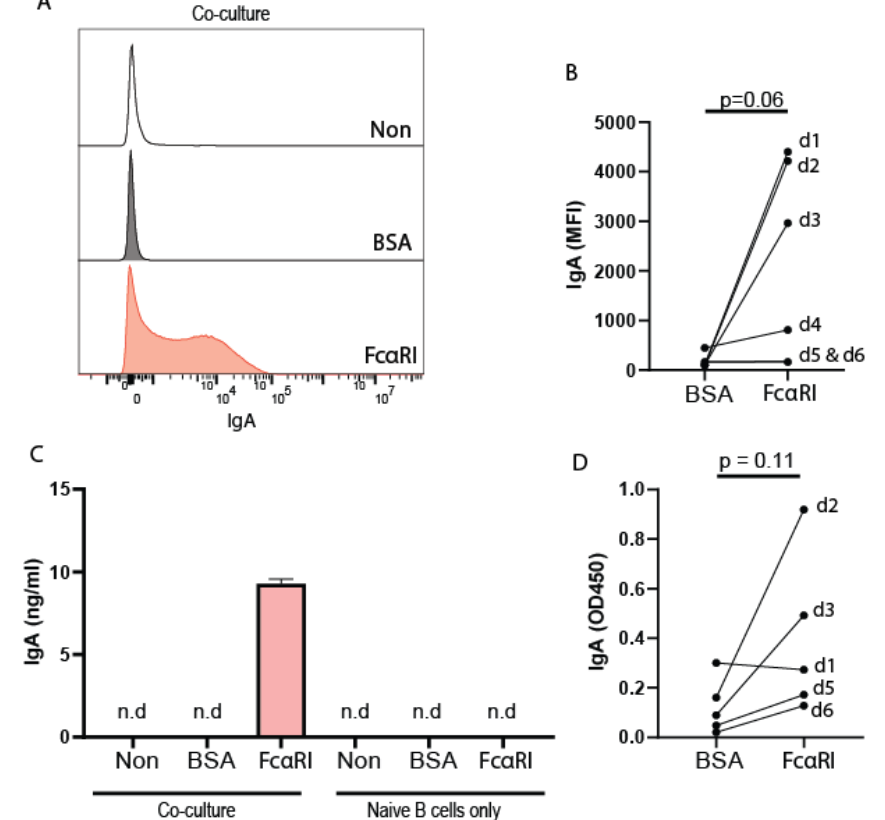
Figure 5. Fc α RI-stimulated monocytes induce IgA class switching in naïve B lymphocytes. Mono- cytes were stimulated with BSA- or IgA-coated (activating Fc α RI) beads and cocultured with pe- ripheral naïve B cells for 7 days in the presence of interleukin-4, anti-IgM, and anti-CD40 antibodies. ( A ) Representative histogram demonstrating IgA surface expression by B lymphocytes after cocul- ture with monocytes treated without beads (non; white), with BSA-coated beads (gray) or IgA- coated beads (Fc α RI) (red). ( B ) Quantification of the mean fluorescent intensity of IgA on B lympho- cytes of six donors. ( C ) Representative ELISA demonstrating secreted IgA in the supernatants of co- cultured naïve B cells with monocytes treated without beads (non), with BSA-coated beads, or with IgA-coated beads (red). Naïve B cells in the absence of monocytes were cultured with beads as a negative control. ( D ) Quantification of IgA secretion by B cells in five donors. Donor numbers in ( B , D ) correspond. Not enough supernatant of d4 was available to analyze IgA secretion. Data are presented as the mean ± SD.